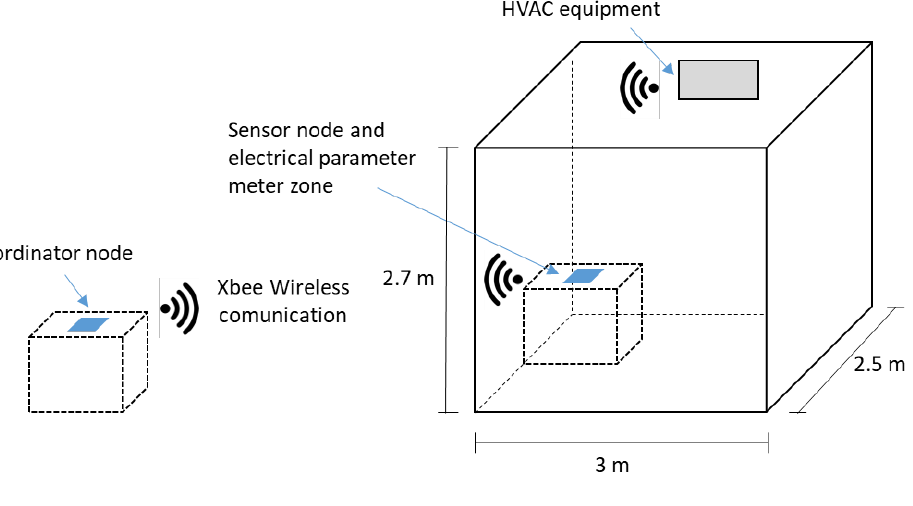
Figure 11. Tests room schema.